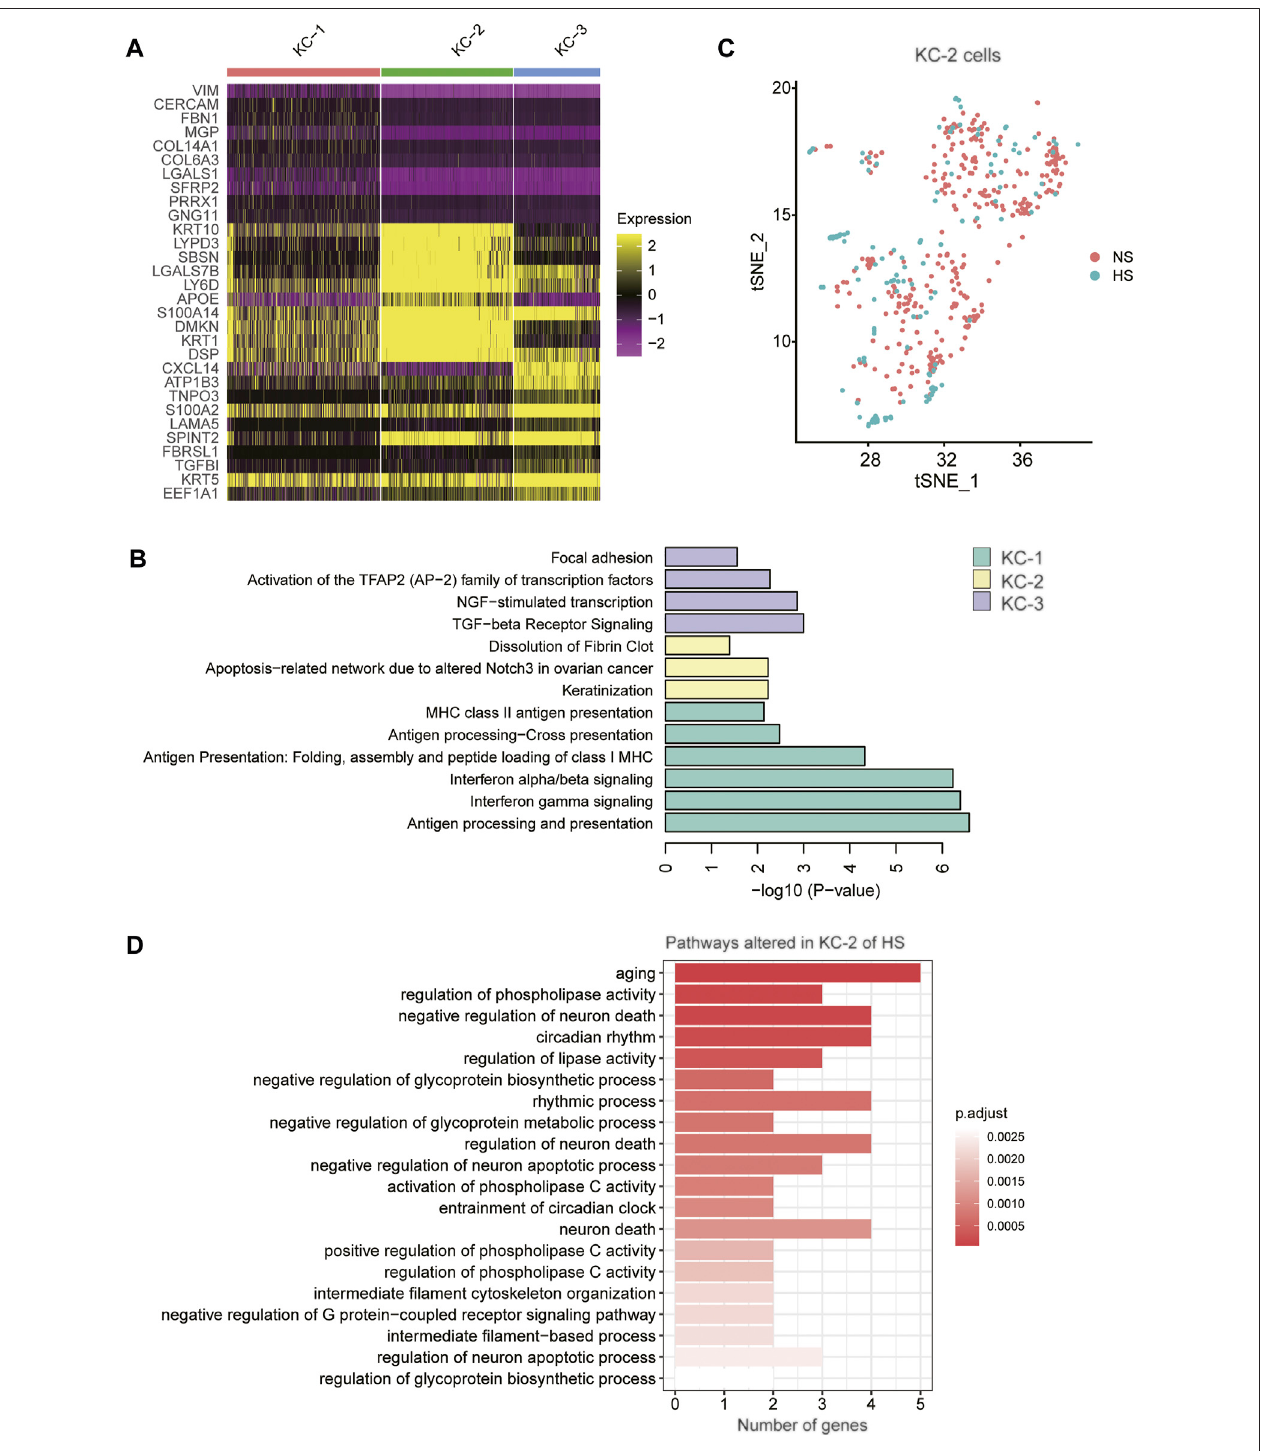
FIGURE 5 | The keratinocyte subpopulations in the skin samples. (A) The expression speci fi city of the KC subpopulation speci fi c genes across the KC cell populations. (B) The subpopulation speci fi c biological functions across the KC subpopulations. (C) The clustering of the KC-2 cells grouped by disease (HS vs NS). (D) The representative biological functions in KC-2 cells of